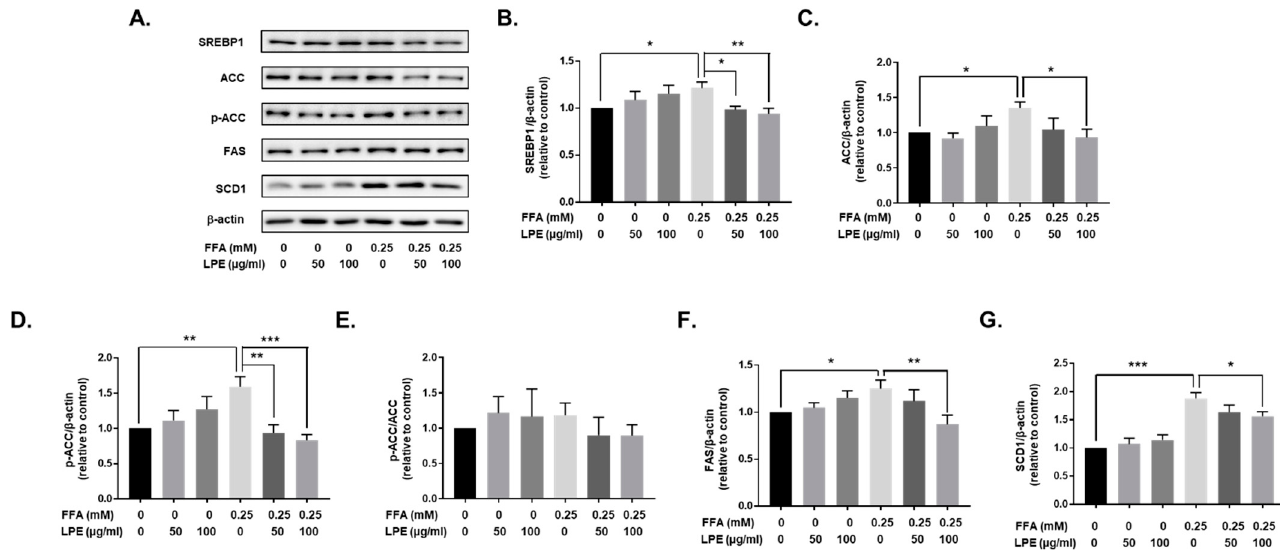
Figure 6. LPE treatment decreased the expression of proteins involved in lipogenesis in FFA-treated HepG2 cells. SREBP1, ACC, p-ACC, FAS, and SCD1 protein expressions were analyzed by Western blotting. Beta-actin was used as the loading control for equal amounts of protein. ( A ) Representative immunoblots of SREBP1, ACC, p-ACC, FAS, and SCD1, together with the relative intensity levels of ( B ) SREBP1, ( C ) ACC, ( D ) p-ACC, ( E ) p-ACC/ACC, ( F ) FAS, and ( G ) SCD1, were normalized to β -actin. Data are shown as mean ± SEM, n = 5/group, * p < 0.05, ** p < 0.01, *** p < 0.001. One-way ANOVA was performed along with Fisher’s protected least significant difference test.